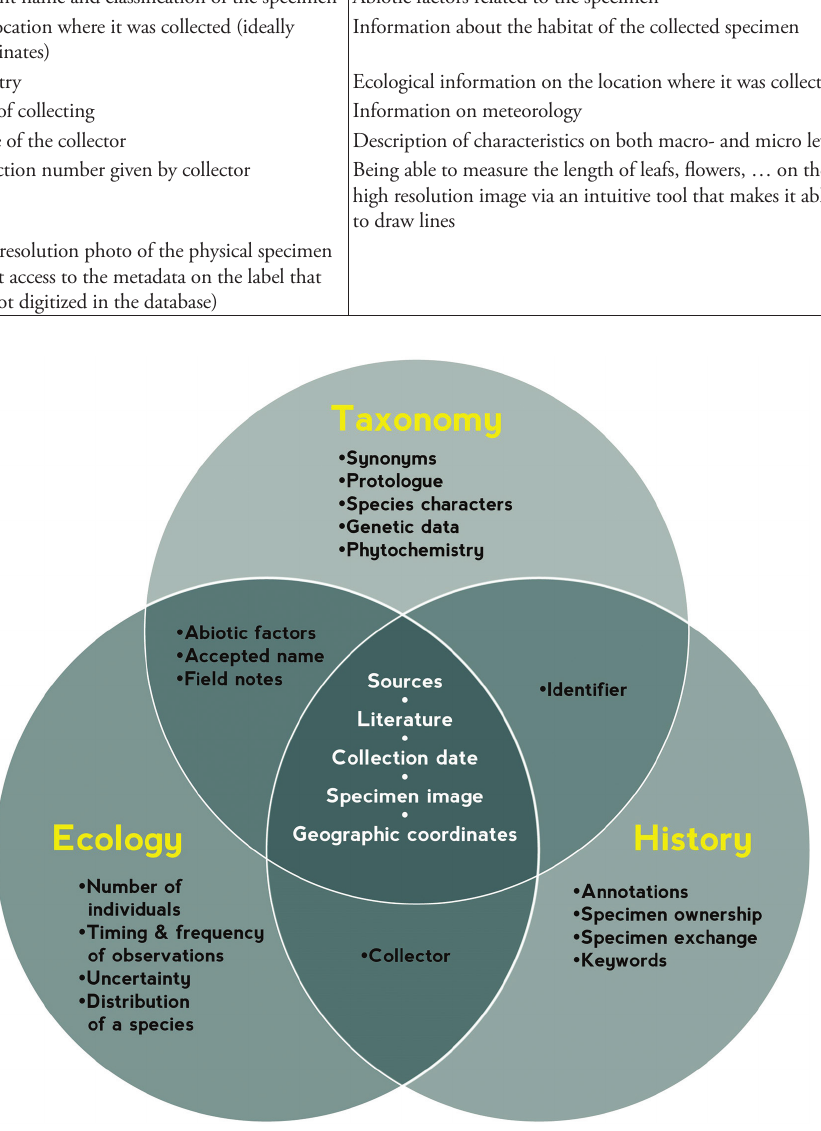
Figure 3. A summary of the data elements mentioned by the different researcher types, showing which data elements researchers had in common and which were unique. This does not mean that any particular data element is not of interest to another group, only that it did not arise in the series of interviews. De- tails of these data elements can be found in the supplementary information. The full list of common data elements is listed in Table 2.